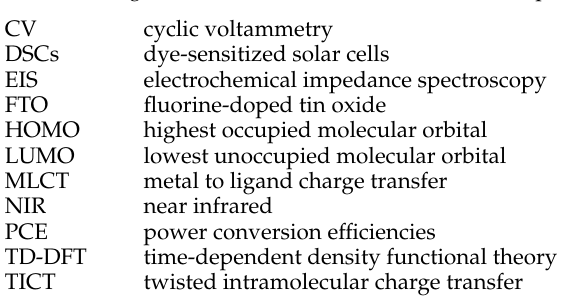
intermediate 1. Figure S3: 1 H NMR of intermediate 2. Figure S4: 1 H NMR of VG2-C8. Figure S5: 1 H NMR of VG3-C8. Figure S6: 1 H NMR of VG11-C8. Figure S7: 1 H NMR of VG12-C8. Figure S8: Cyclic voltammograms of VG2-C8, VG3-C8, VG11-C8 and VG12-C8 at scan rate 100 mV ¨ s ´ 1 , 2nd scan is shown. Figure S9: Upper